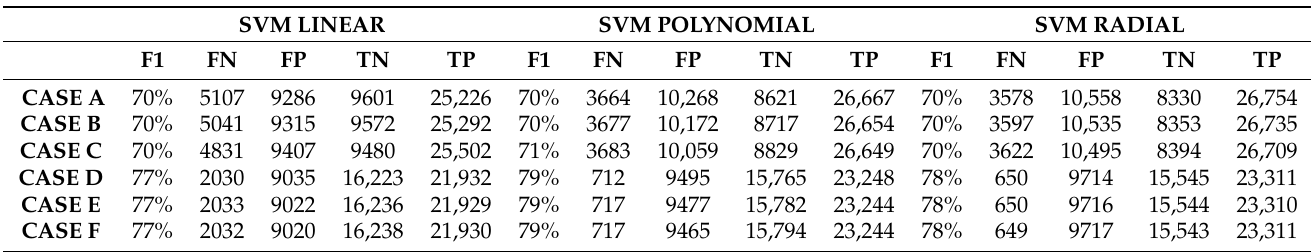
Table 4. Accuracy metrics for Support Vector Machines (SVM) with linear kernel, polynomial kernel, and radial kernel. F1 score (F1), FN, FP, TN, and